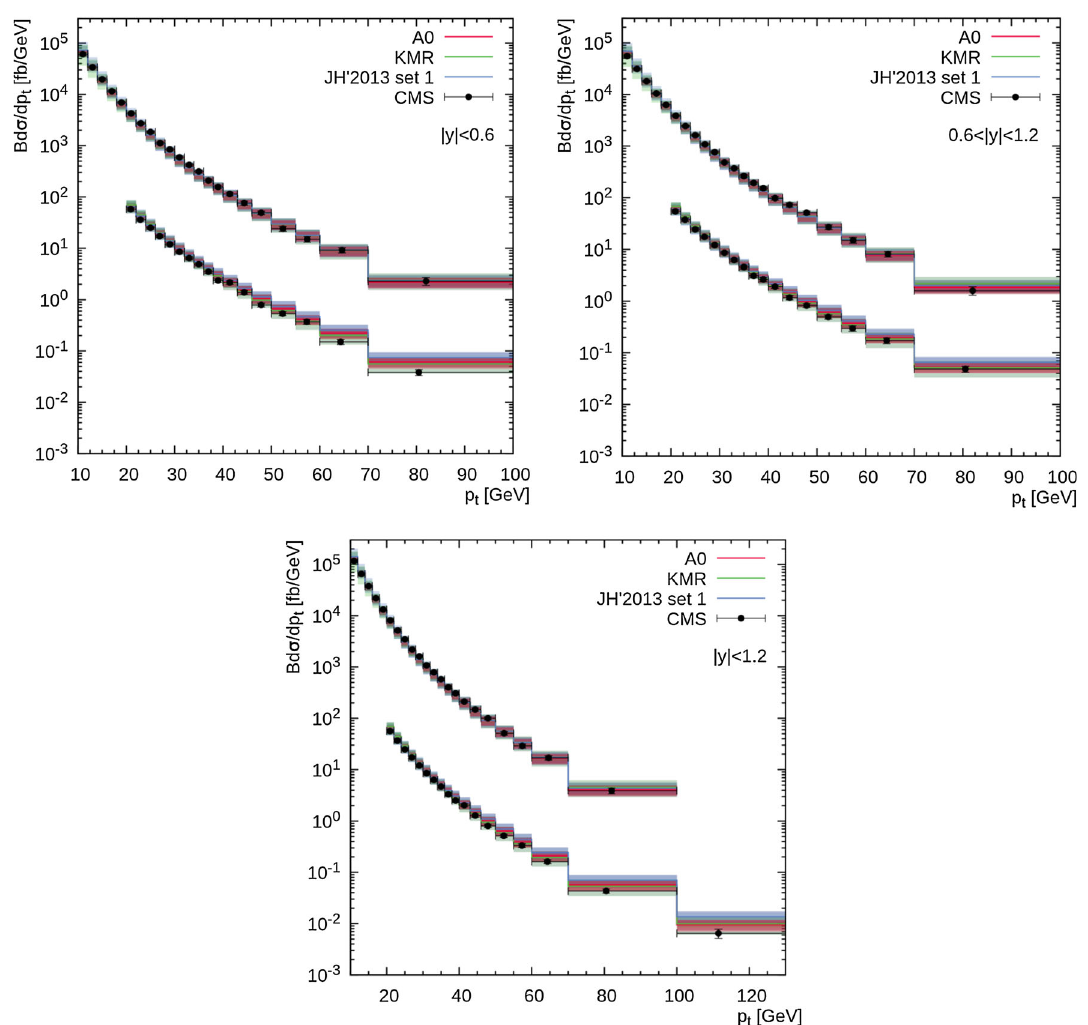
Fig. 2 Transverse momentum distribution of the inclusive ϒ( 1 S ) pro- √ s = 7TeV(upperhistograms)and ductioncalculatedat (lower histograms, divided by 100) in the different rapidity regions. The tum S z during the transformation of color octet 3 S